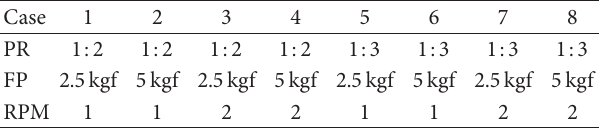
Figure 2: Schematics of the twin-roll press machine for continuous pelletizing. Table 1: Case of pelletizing using TPCP.